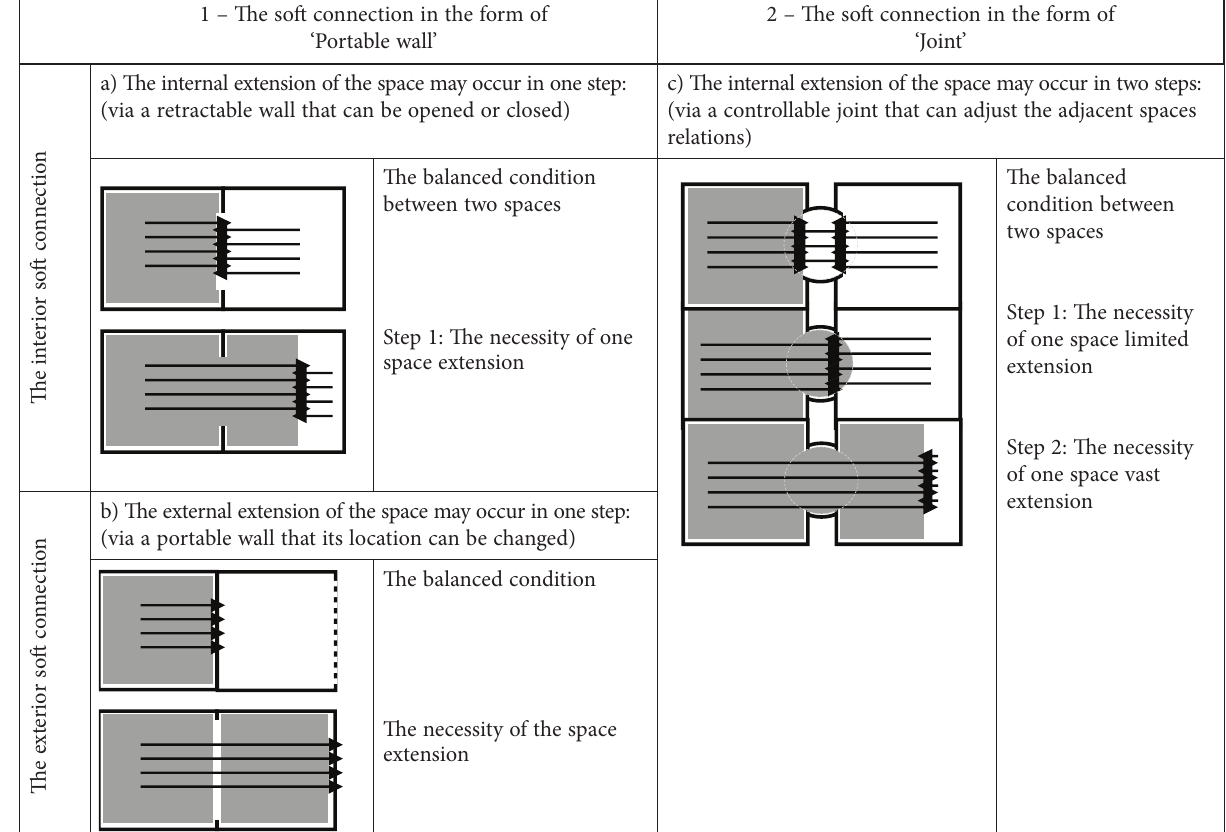
2 – The soft connection in the form of ‘Joint’1 – The soft connection in the form of